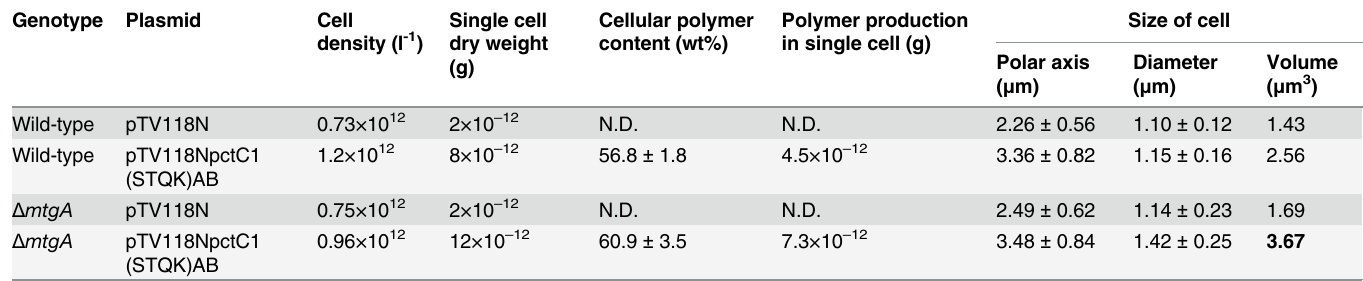
Table 3. Correlation between polymer production and cell volume in recombinant E . coli with mtgA deletion. Genotype